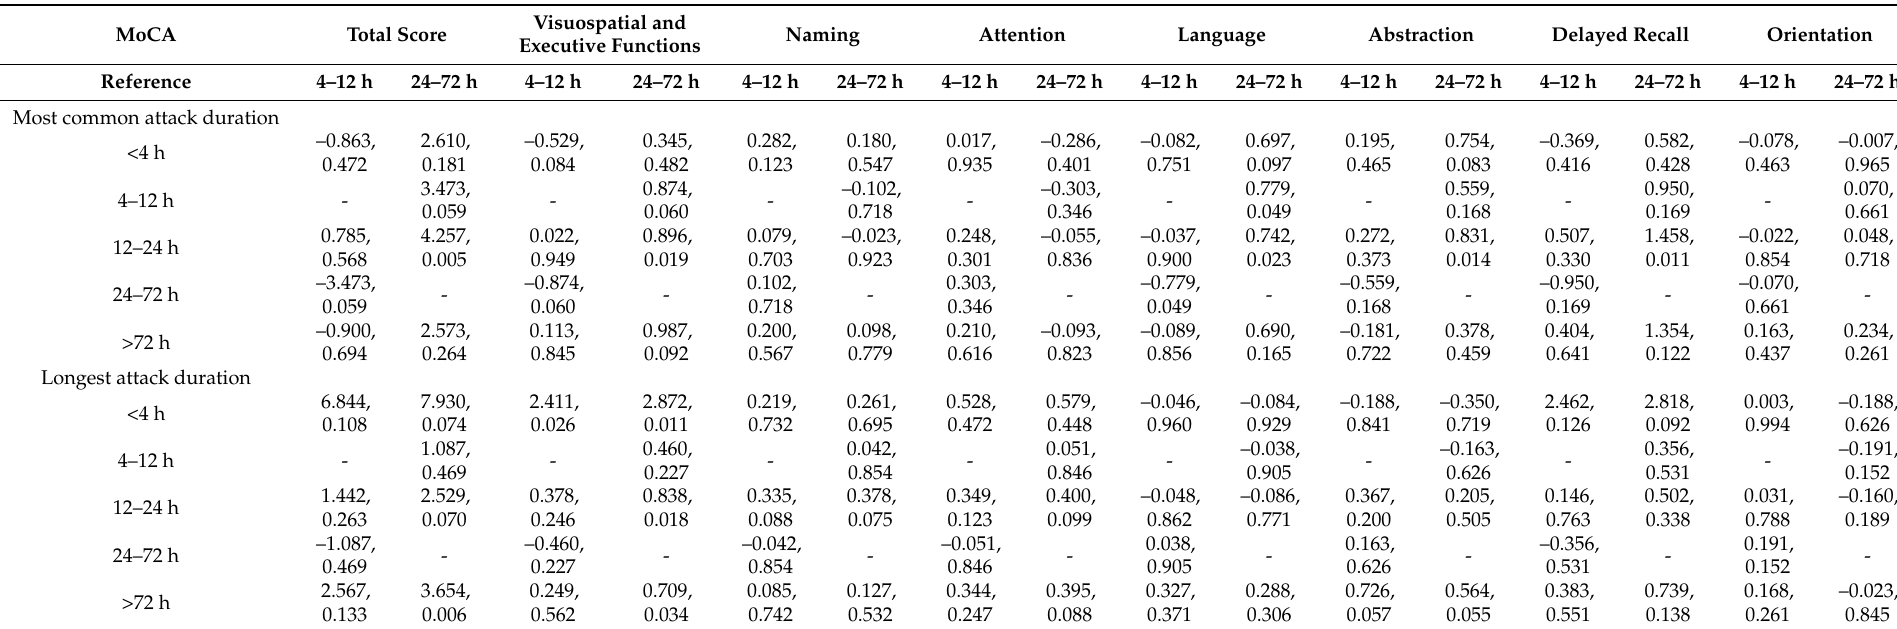
Table 10. Multiple linear regression analysis of the factors influencing MoCA total and subset scores in migraineurs: attack